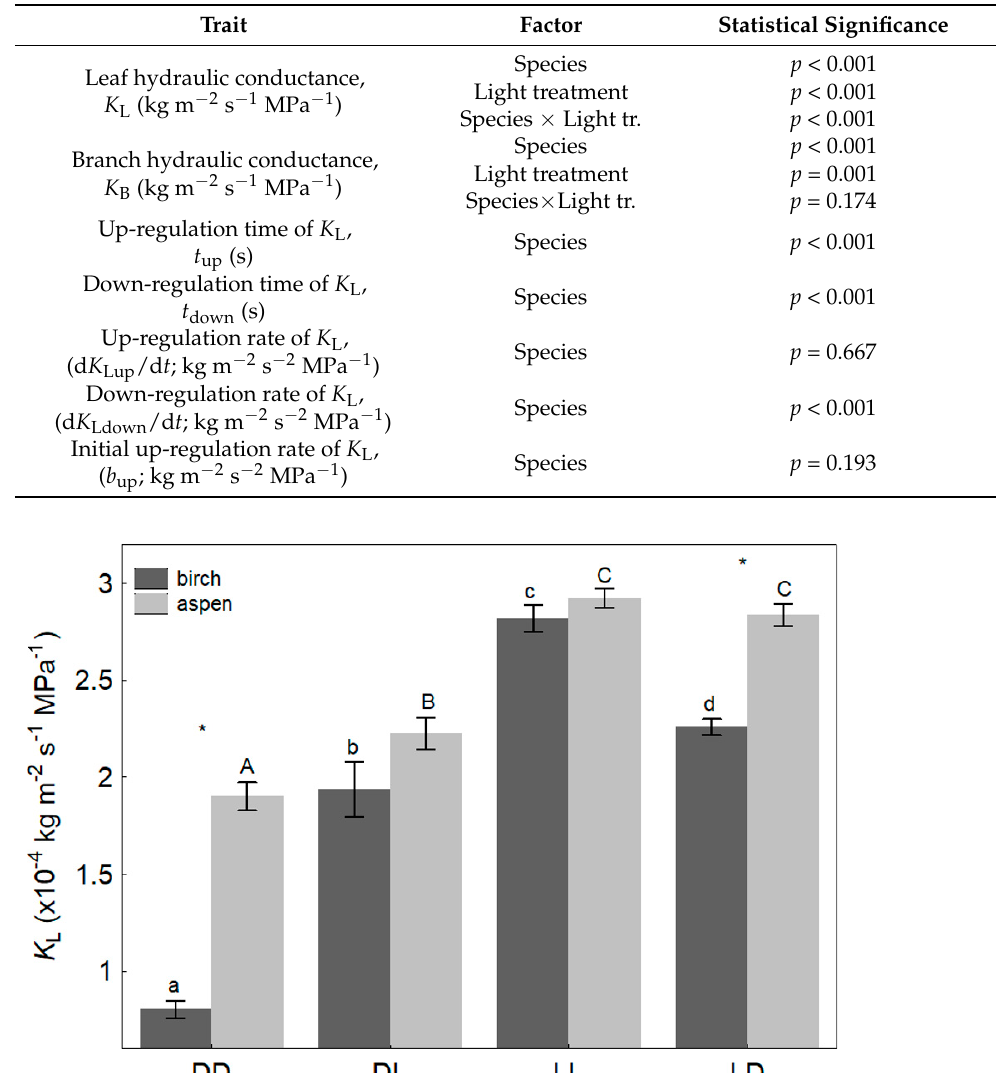
Table 2. Results of ANOVA for the effects of species and light treatment on leaf and branch hydrau- lic properties.